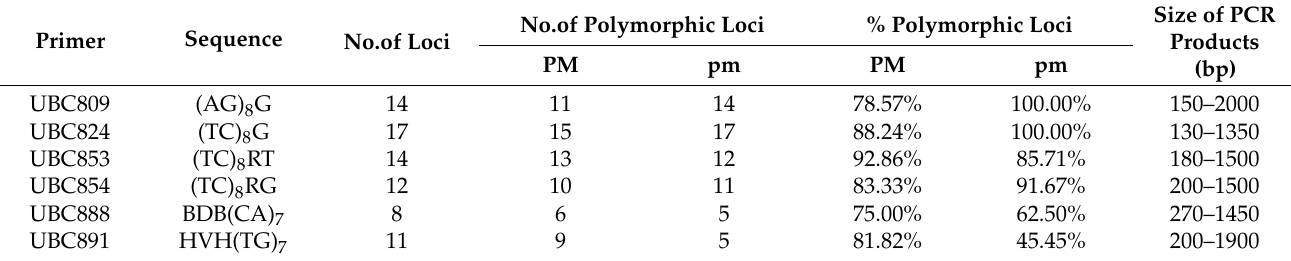
Table 1. Total number of scored bands generated for selected